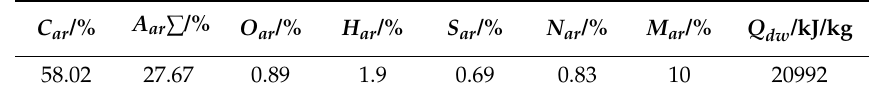
Table 2. Coal analysis properties in case study power